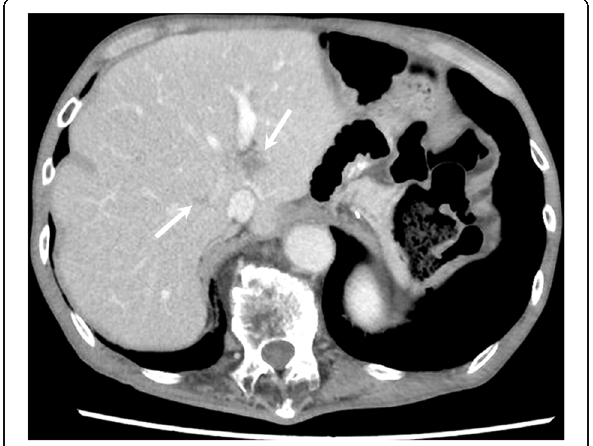
Fig. 2 Abdominal computed tomography (CT) findings after four cycles of nivolumab. Abdominal enhanced-contrast CT revealed a marked reduction (by 55%) in liver metastases (arrows)